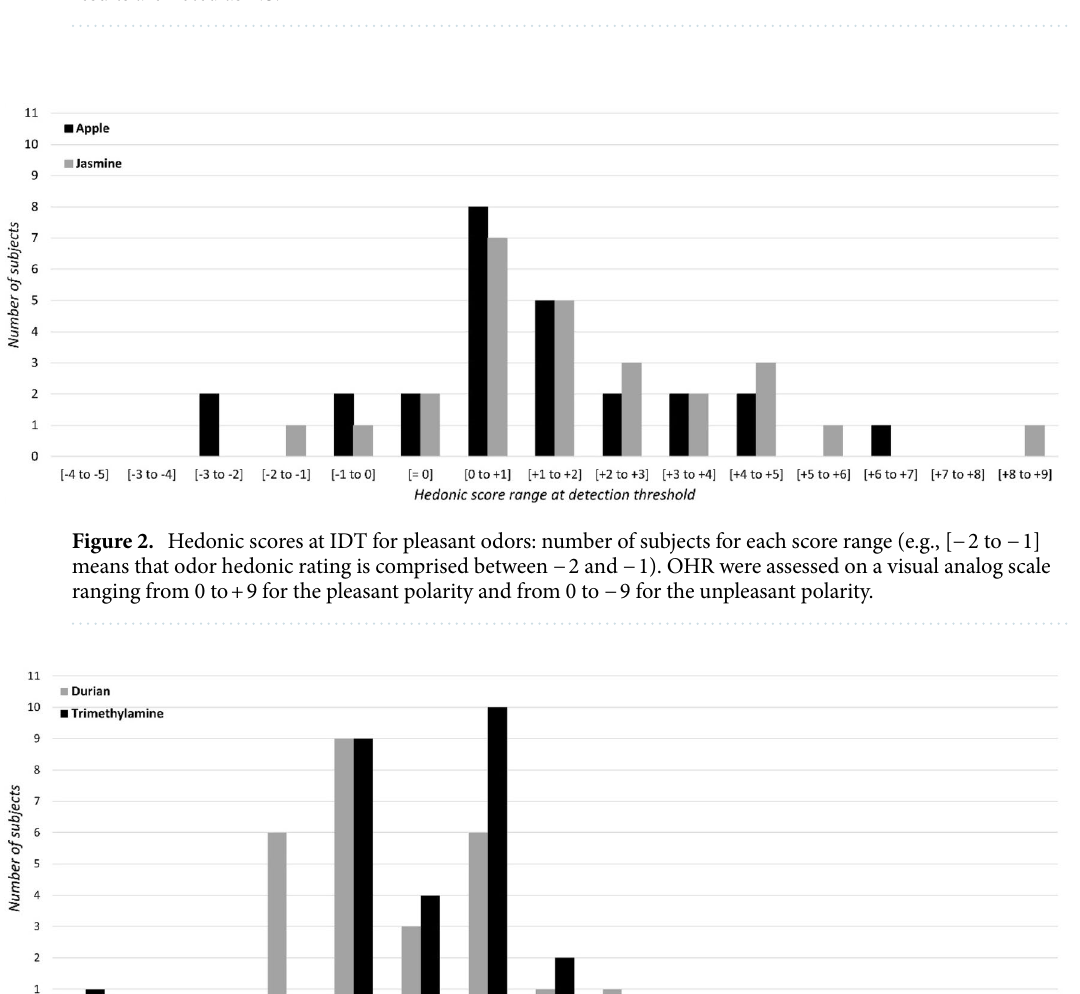
Table 1. Spearman correlations between IDT. Significant results were considered for p < 0.05. Non-significant results are noted as NS.